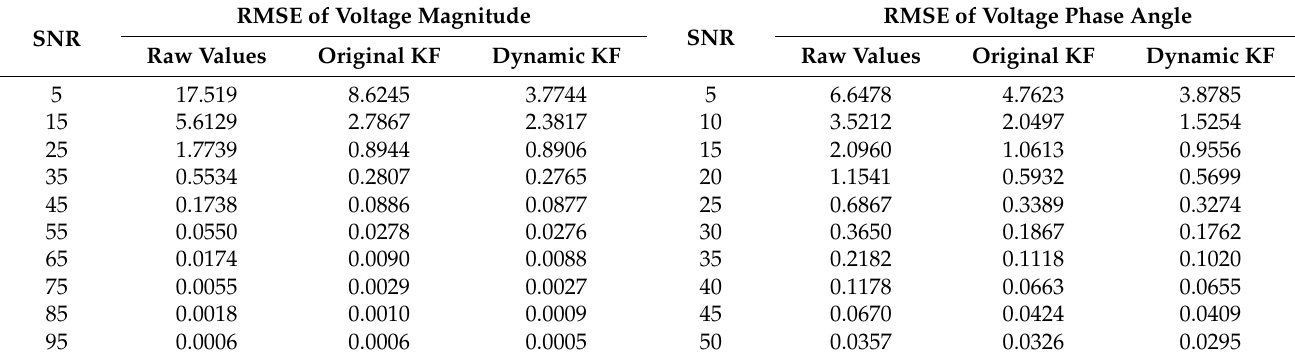
RMSE of Voltage Phase Angle SNR